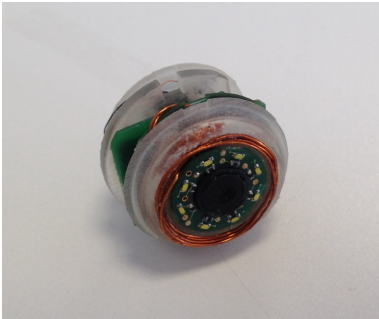
Figure 10. Capsule with integrated wireless recharging system.